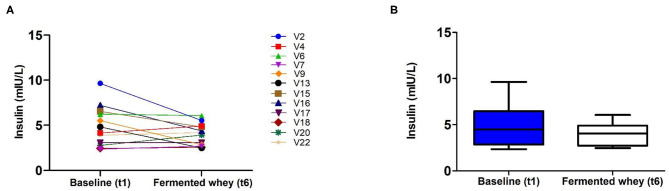
Fasting insulin profiles pre- (t1) and post-intervention, t6 (n = 12). (A) Insulin concentration shown by individual volunteers, at baseline (t1) and after the intervention (t6). (B) Group average fasting insulin levels. There was a reduction of −0.9 mUI/L which failed to reach significance (p = 0.089).